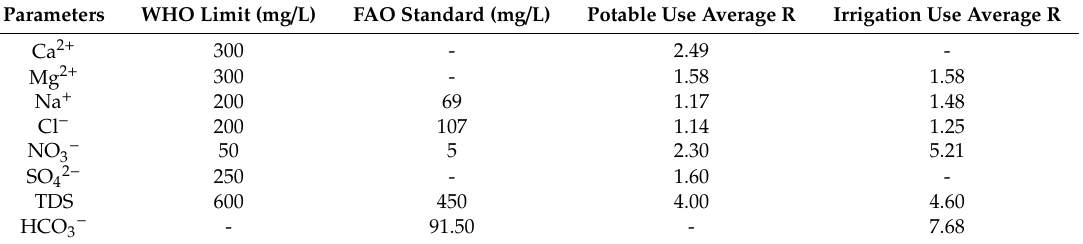
Table 2. Statistics of the parameters rank utilized to compute Groundwater Quality Index (GQI).